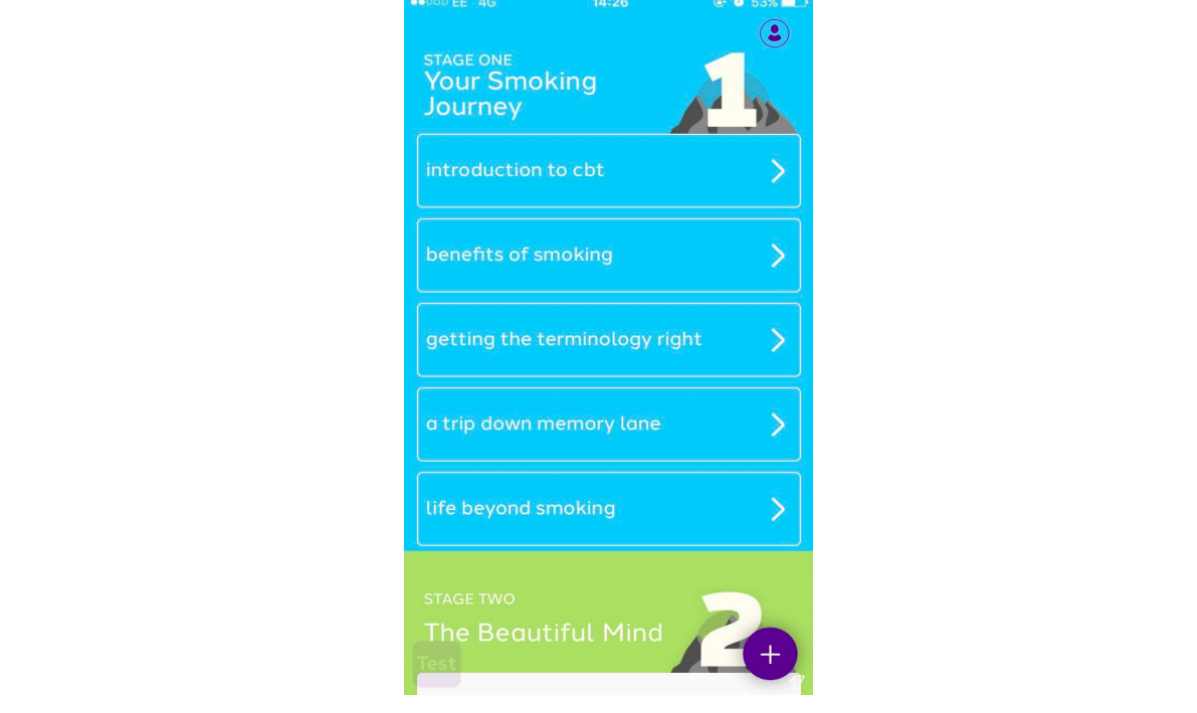
Figure 2. Screenshot of the NHS SmokeFree